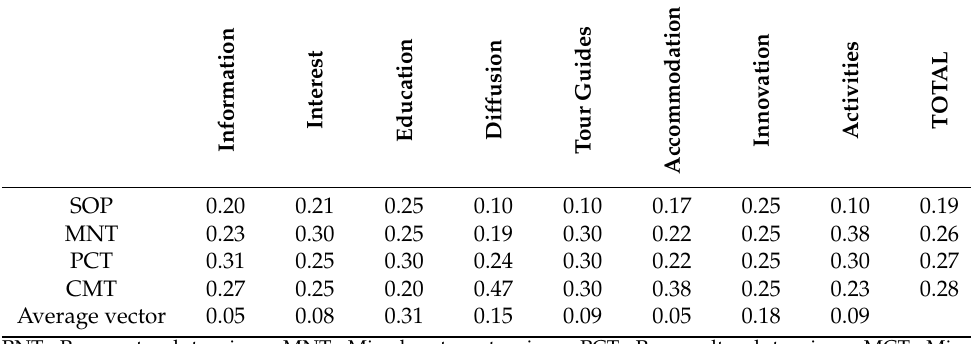
Table 10. Matrix of weighted